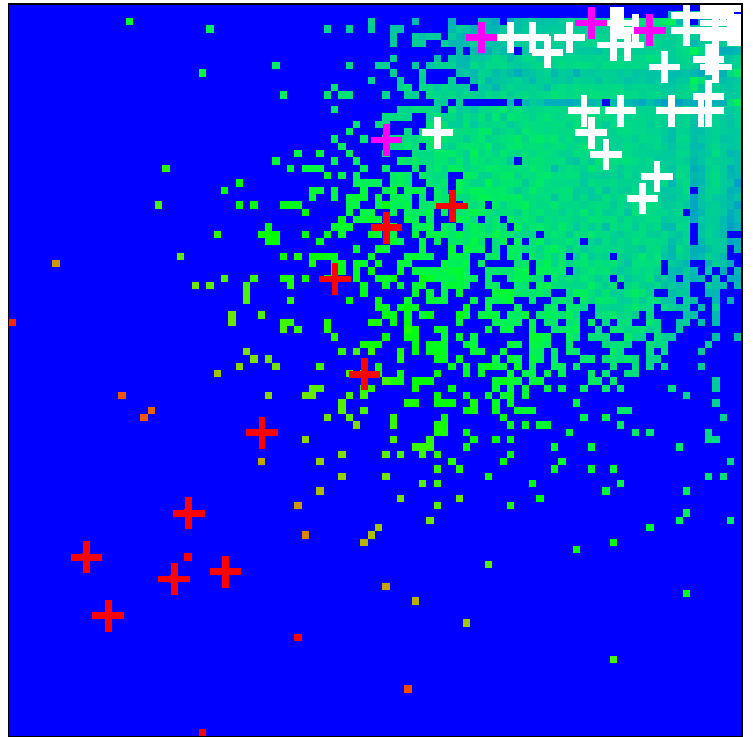
∗ ) on PageRank–CheiRank plane ( K ) averaged over Figure 1. Density of nodes W ( K M , K ∗ M , K M M ∗ ≤ ln N (1 ≤ K ≤ N = 40,079); 100 × 100 logarithmically equidistant grids for 0 ≤ ln K M ,ln K ∗ M , K M M the density is averaged over all nodes inside each cell of the grid, the normalization condition is ∗ ∑ ( K ) = 1. Color varies from blue at zero value to red at maximal density value. In M , K K M , K ∗ M W M order to increase the visibility, large density values have been reduced to (saturated at) 1/16 of the actual maximum density and typical green cells correspond to density values of ∼ 1/2 8 of the (reduced) maximum density. The x -axis corresponds to ln K M and the y -axis to ln K ∗ with K M ( K ∗ ) M M being the global PageRank (CheiRank) index for the full MetaCore network. The crosses mark the positions of the 54 proteins of Table 1 with colors: red for the X-proteins, pink for the TGF- β subgroup, and white for the up- and down-protein